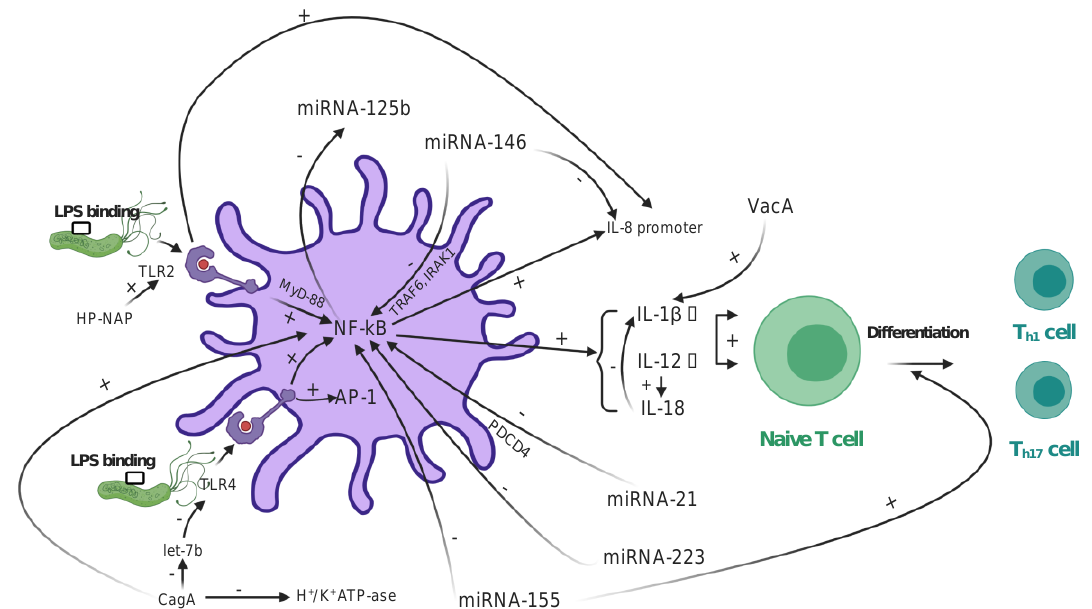
Figure 3. MiRNA involvement in H. pylori nuclear factor-kappa B (NF-kB) dependent pathways. Created with BioRender.com (https://biorender.com/). NF-kB dependent pathways are activated as a result of TLR-2/TLR-4 and LPS interactions and stimulate release of pro-inflammatory cytokines, including IL-12 and IL-1 β , responsible for differentiation of T Helper 1 and Th17 cells. The three main virulence factors of H. pylori positively impact release of inflammatory cytokines, VacA being the only one, which is not directly involved in TLR – LPS interaction. Illustrated miRNAs seem to be able to both negatively modulate NF-kB expression and release of inflammatory cytokines. Furthermore, a few of them are downregulated by CagA (i.e., let-7b) and by NF-kB (i.e., miRNA-155). Legend: CagA — cytotoxin-associated gene A; HP-NAP — H. pylori neutrophil-activating protein; IL — interleukin; Let-7 — lethal 7; LPS — lipopolysaccharide; miRNA — microRNA; NF-kB — nuclear factor kappa B; Th — T helper cell; TLR — toll-like receptor; VacA — vacuolating cytotoxin .